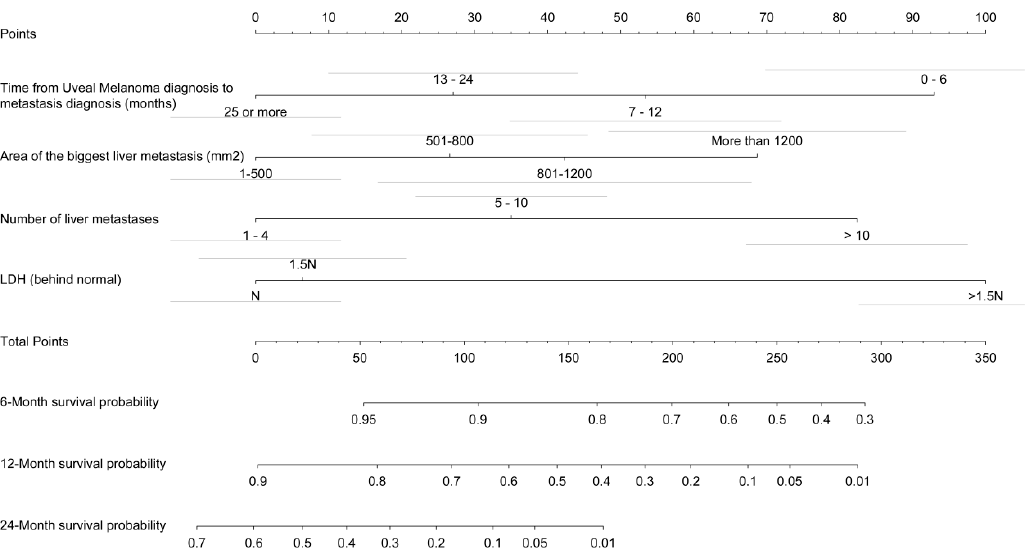
Figure 1. Nomogram of the final prognostic model. The sum of the prognostic factor points corresponds to the survival probability at 6, 12, and 24 months. On the nomogram, the first row corresponds to the row of points for the score of each variable. Next, we divided the prognostic factors into classes. The next line is the total score on which to sum the scores of the 4 variables in the nomogram. The last three lines correspond to the predicted survival at the 3 time points.